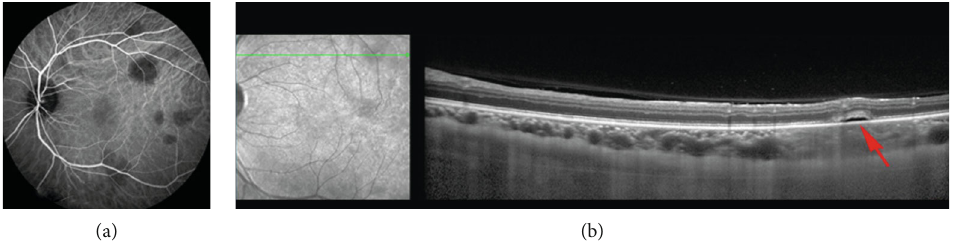
Figure 6: Case 2: ICG angiography and EDI-OCT at presentation (left eye). (a) Indocyanine green angiography demonstrated multiple hypo fl uorescent spots throughout the posterior pole and the midperiphery. (b) Enhanced Depth Imaging-OCT performed on a superotemporal hypocyanescent spot revealed a well-delineated lesion occupying all the choroidal space and considered as a cryptococcal granuloma, associated with a small serous retinal detachment (red